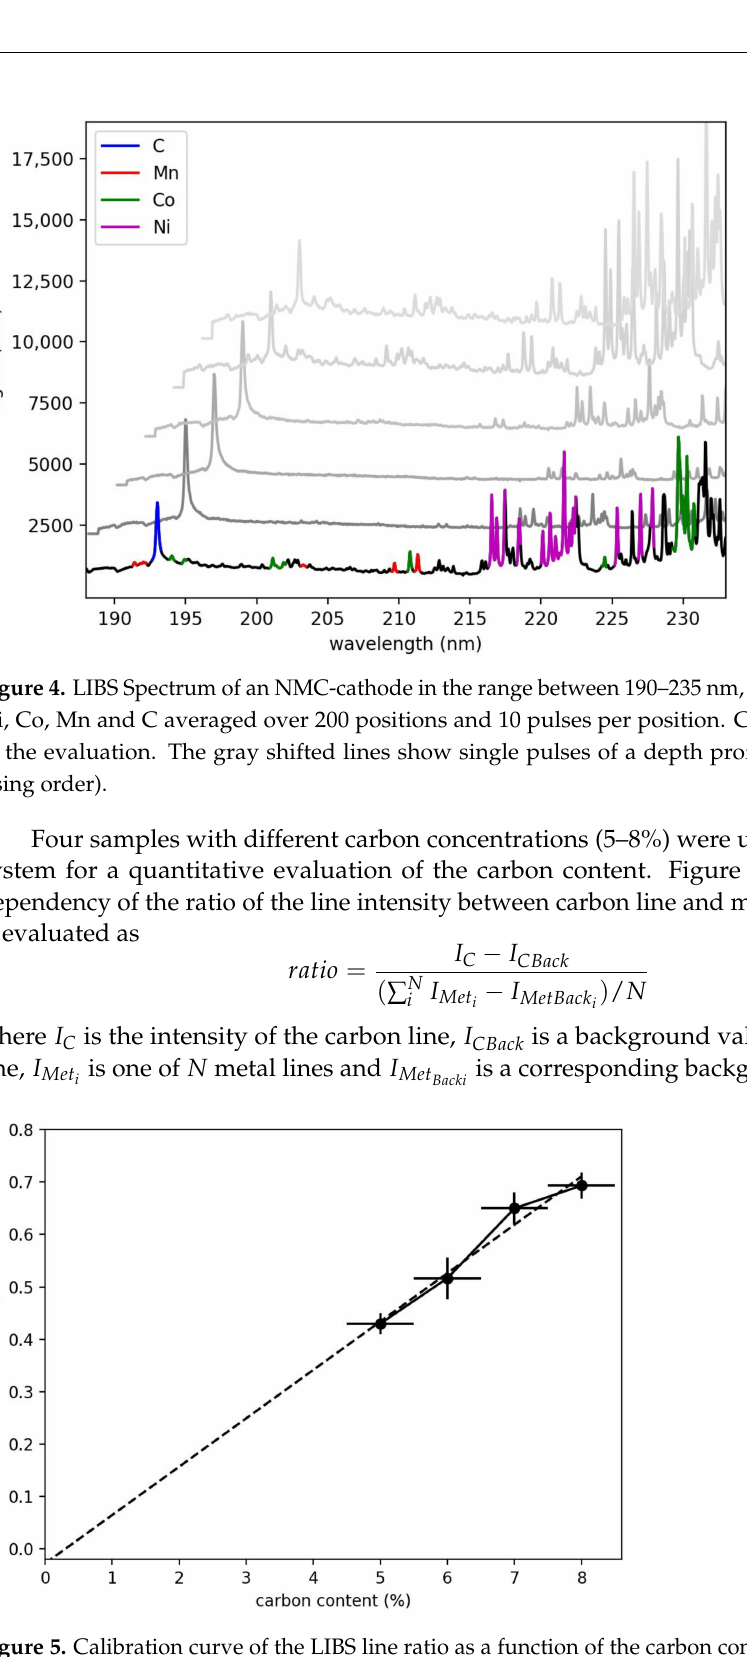
Figure 5. Calibration curve of the LIBS line ratio as a function of the carbon content. The error on the x-axis is the assumed error in preparation; the error on the y-axis is derived from three measurements. As the spectra of single pulses show a big variance, from pulse-to-pulse spectra from 400 positions with 10 spectra at each position (depth profile) were averaged. Pulse-to-pulse variations are mainly due to the distribution of the NMC beads